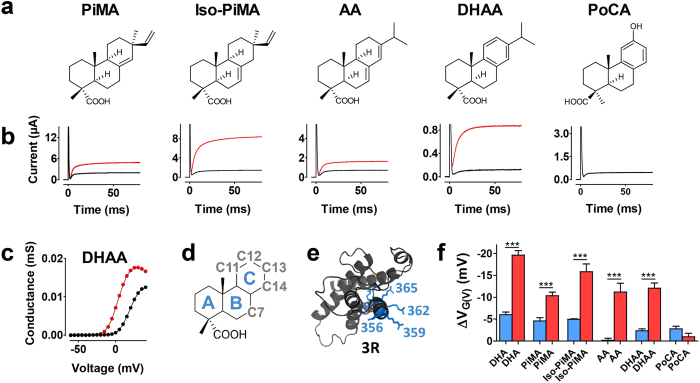
The effect of several natural resin acids on the opening of the Shaker K channel.(a) Molecular structure (from left to right) for pimaric acid (PiMA) (1), isopimaric acid (Iso-PiMA) (2), abietic acid (AA) (3), dehydroabietic acid (DHAA) (4), and podocarpic acid (PoCA) (5). (b) Representative current traces for voltages corresponding to 10% of maximum conductance in control solution at pH 7.4 of the 3R Shaker K channel. Black traces indicate control, and red traces 100 μM compound (same order as in a). (c) Representative G(V) curves for DHAA effects, same cell as in b (control, black symbols; DHAA, red symbols. ∆VG(V) = −15.5. (d) Ring nomenclature of the general compound skeleton (blue) and modified carbons in derivates (grey). (e) Gating charge residues (362 = R1, and 365 = R2) and mutated residues (shown as R) of the 3R Shaker K channel (359R, and 356R) are marked on one VSD of the Shaker K channel in the active state. (f) Compound-induced G(V) shifts for the WT (blue) and 3R Shaker K channel (red). Mean ± SEM (n = 9, 15, 15, 6, 4, 4, 5, 5, 10, 6, 4, and 6 from left to right). Data for DHA (6) and PiMA (1) are from ref 17. The shifts of WT and 3R Shaker K channel are compared for each compound (one-way ANOVA together with Bonferroni’s multiple comparison test: *P < 0.05; ***P < 0.0001).